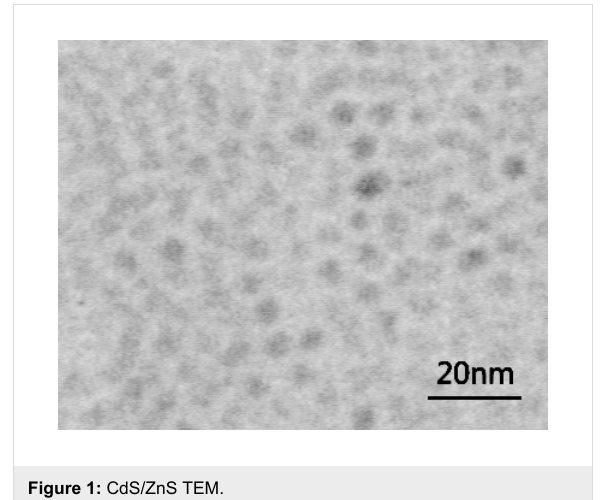
Figure 1: CdS/ZnS